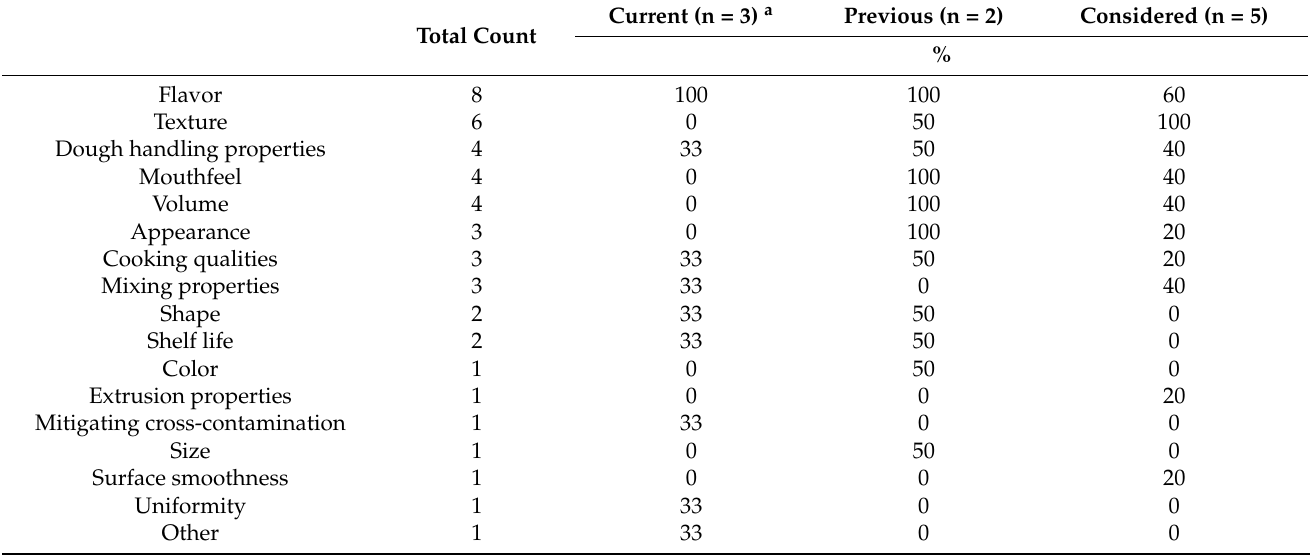
Table 10. Challenging product qualities produced using the pulse flours that the 10 CPC users selected who reported they encountered